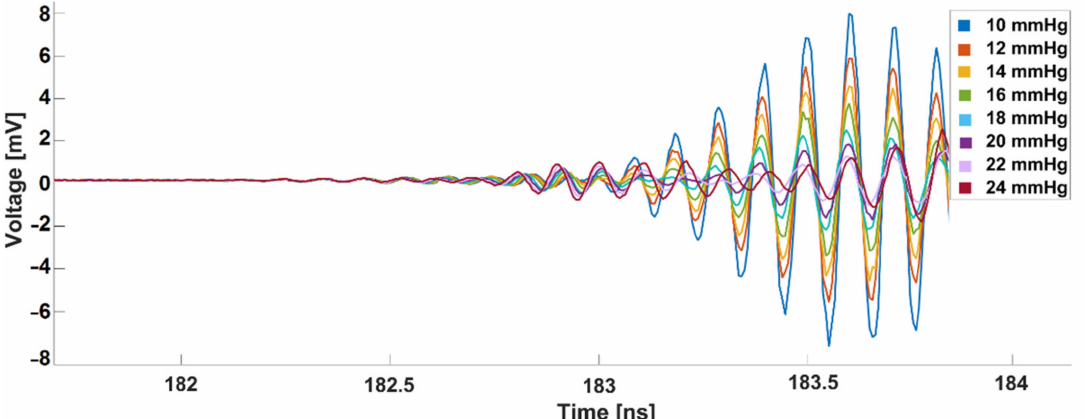
Figure 5. Smoothed reflected signals from the abdominal wall phantom. By means of averaging and histogram techniques, the raw transient signals were converted into the smoothed ones. The highest resolution was found at 183.6